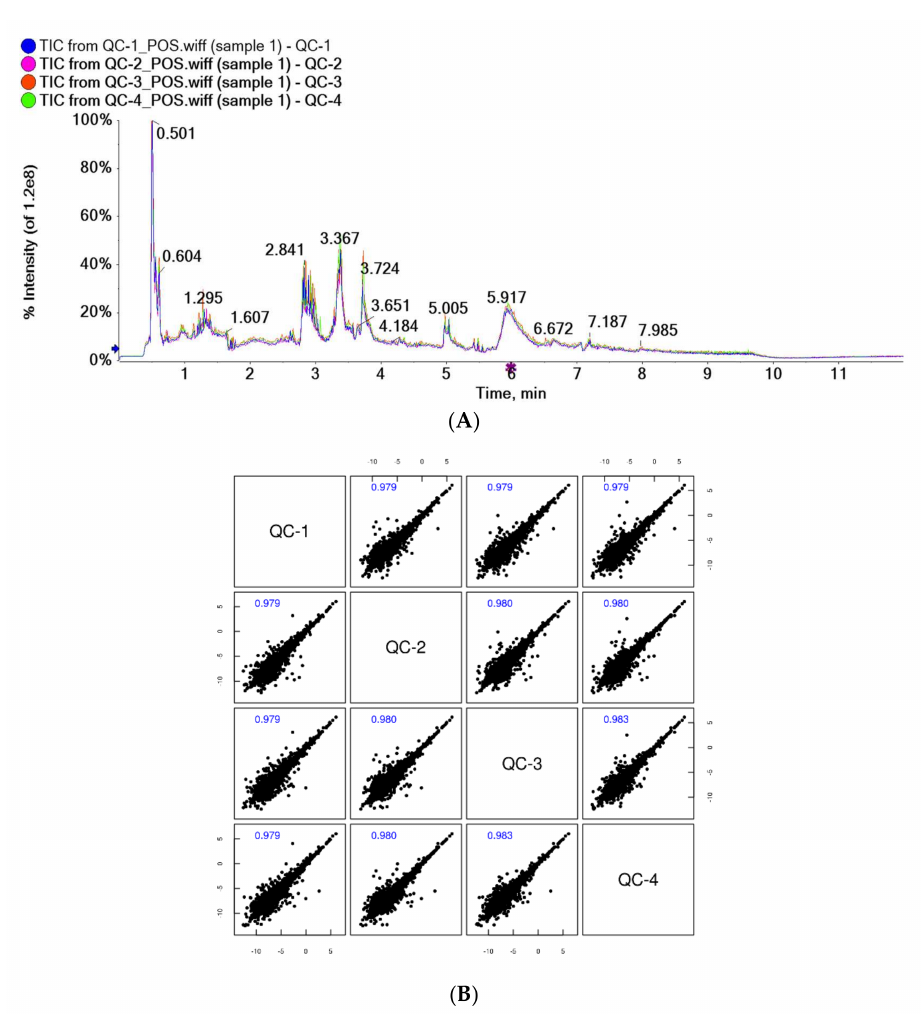
Figure 1. Overlapping spectra of TIC of QC samples in positive ion mode ( A ); correlation spectra of QC samples in positive ion mode ( B